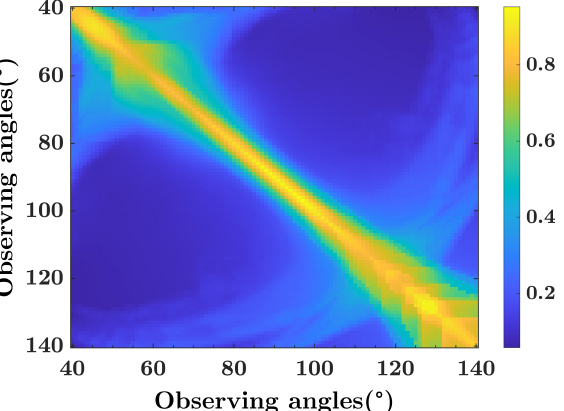
Figure 3. Relative standard deviation versus observing angles with dual-wavelength LED.